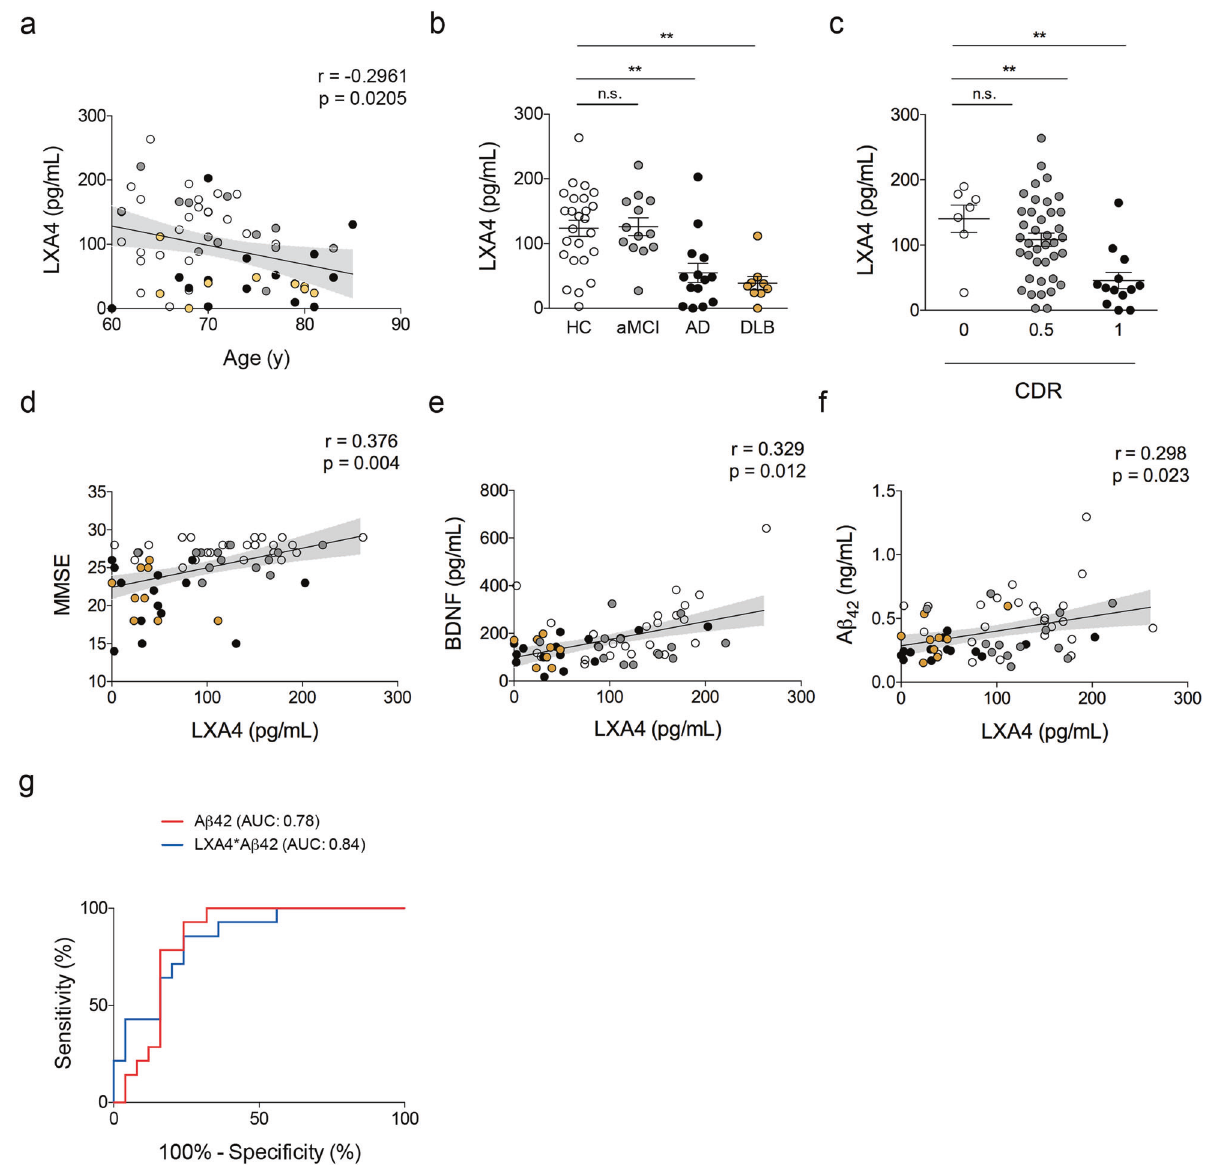
Fig. 4 Cerebrospinal fl uid LXA4 is reduced in aging and in dementia in humans. a Correlation between age (in years) and CSF LXA4 in human subjects. b CSF levels of LXA4 in AD and DLB patients compared to healthy controls or amnestic MCI patients ( N = 25 controls, 13 aMCI, 14 AD, 9 LBD patients). c CSF LXA4 categorized by clinical dementia rating (CDR) ( N = 7 CDR 0; N = 40 CDR 0.5; N = 13 CDR 1). Two-tailed unpaired one-way ANOVA followed by Holm – Š idák post hoc test (** p < 0.01; ns nonsigni fi cant). Graphs show means ± standard error of the mean (SEM). d – f Correlations between LXA4 and MMSE scores ( d ), CSF BDNF ( e ), or A β 42 ( f ) levels in human subjects. Lines represent partial rank correlations (r and p -values as indicated in graphs), adjusted for age, and the con fi dence interval is represented as gray shade. g Receiver operating characteristic curves for diagnostic based on A β 42 alone (red line) or LXA4*A β 42 (blue line); con fi dence interval: 0.95; p < 0.001. HC healthy controls, white symbols, aMCI amnestic mild cognitive impairment, gray symbols, AD Alzheimer ’ s disease, black symbols, DLB dementia with Lewy bodies, golden symbols, AUC area under the